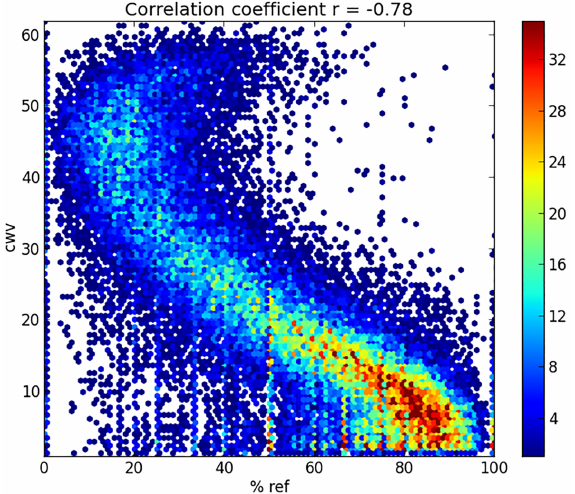
Figure 8. Two-dimensional histogram of occurrence of reflections, computed monthly on 10 ◦ × 10 ◦ ocean cells, against the column of water vapour averaged over the same cell and month. ECMWF ERA interim data have been used to estimate the values of the Column of Water Vapour (CWV, in kgm − 2 ). The colour scale represents the number of (cell × month) counts, and it has been saturated to 35 for clarity. The resulting cross-correlation coefficient between reflec- tion and CWV is r =−